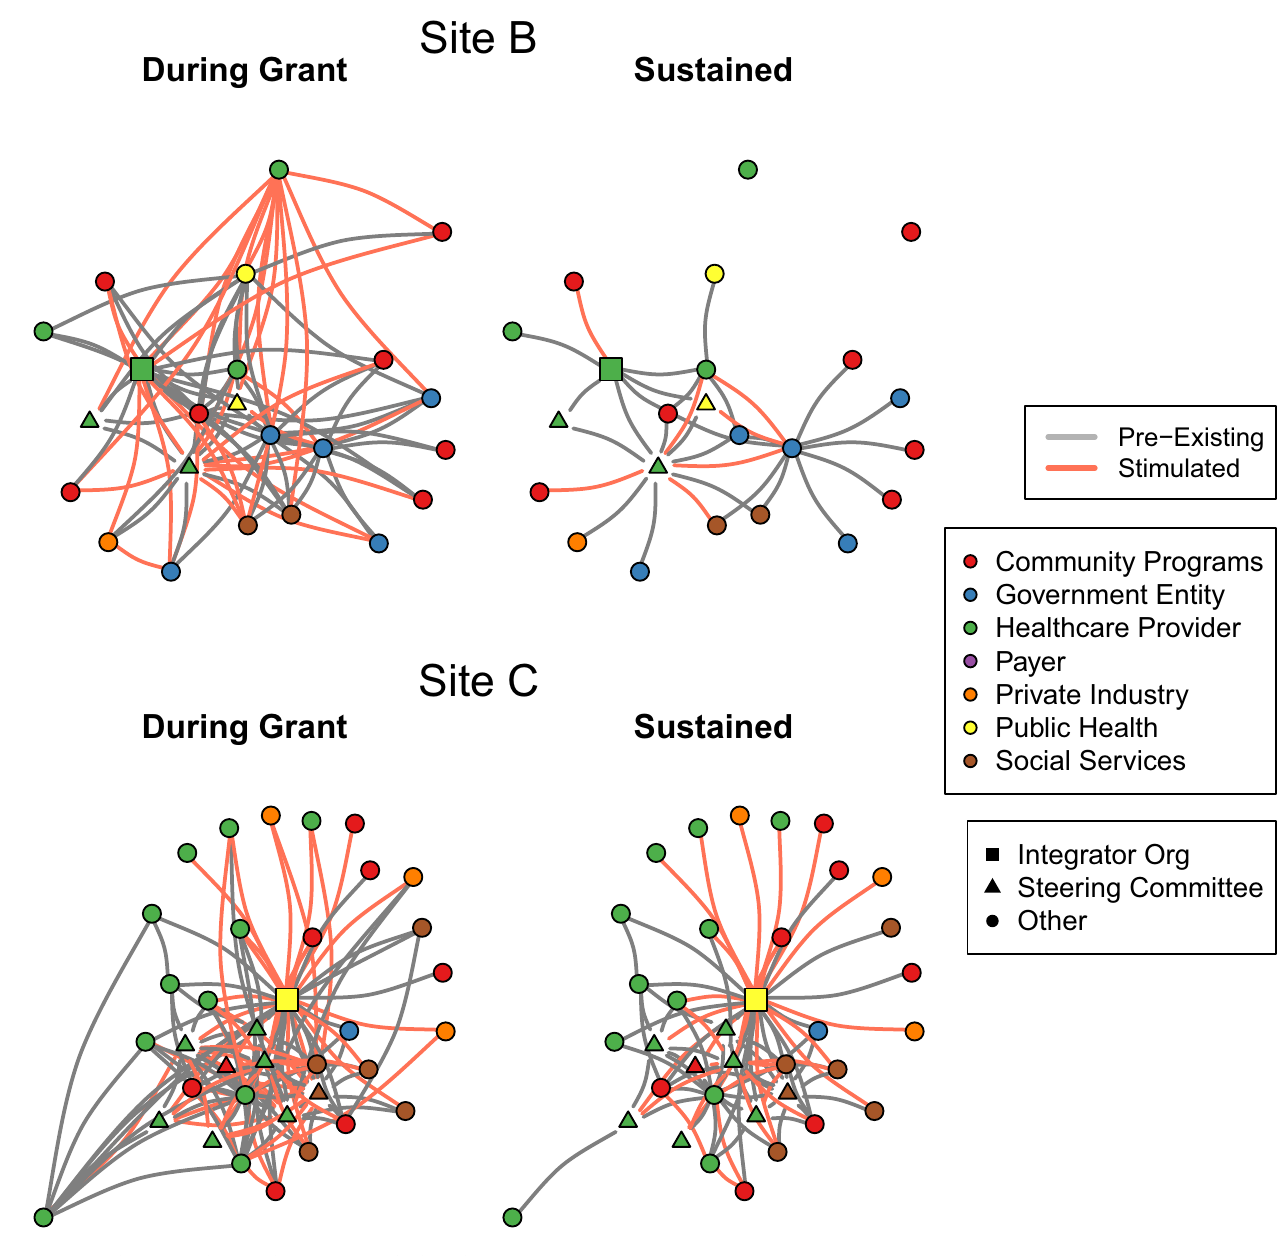
Fig 1. Visualizations of network summaries of selected ACH sites in Iowa.